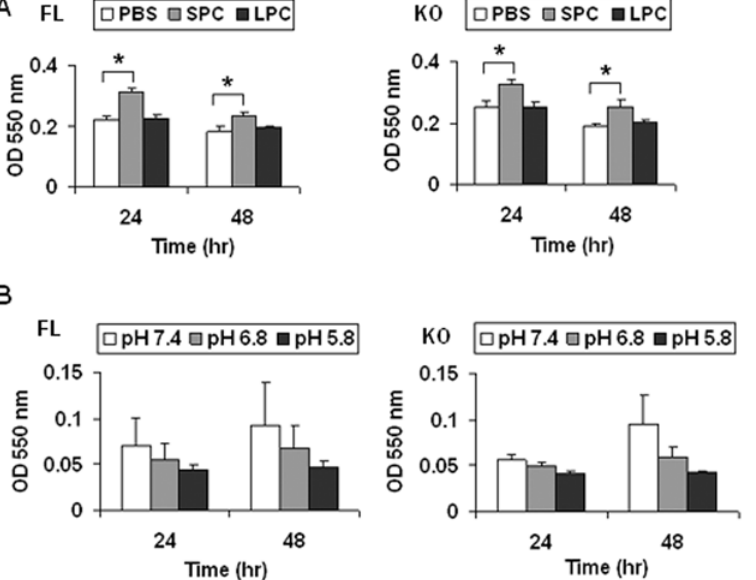
Figure 5. Proliferation of brown adipose tissue-derived cells in OGR1 KO mice in the mixed background. (A) SPC stimulated proliferation was not significantly different in BAT from FL vs. KO mice. SPC (2.5 m M) or LPC (2.5 m M) was used. (B) The effect of pH on proliferation was not significantly different in FL vs. KO. The results in this figure are representative of at least 3 independent experiments. * represents a P value of , 0.05.